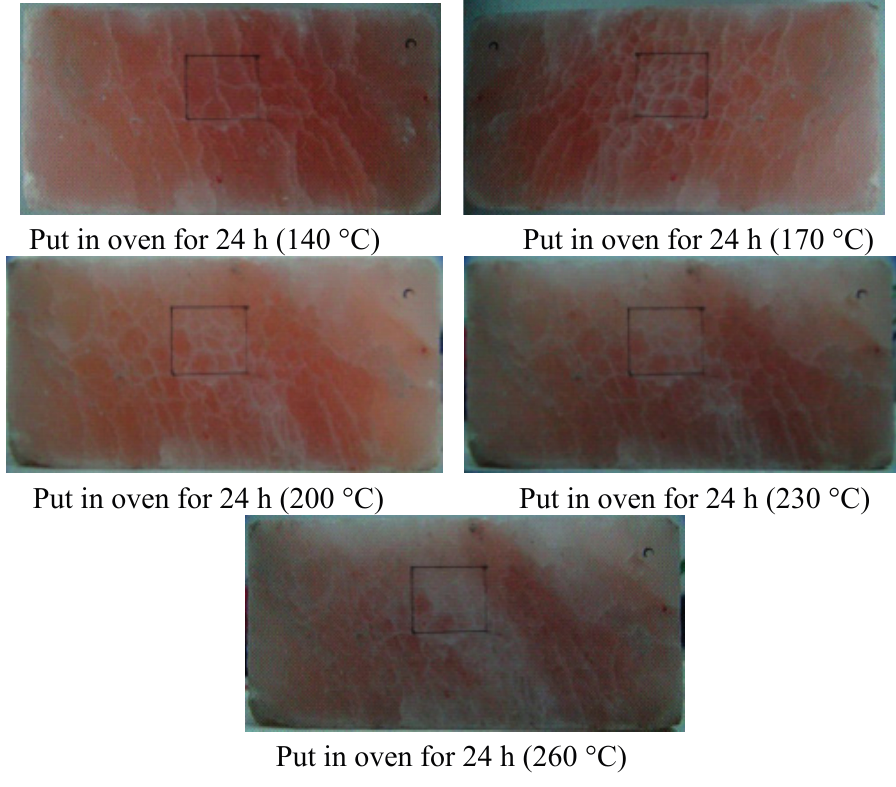
Figure 5. Comparison of the thermal damage cracks on the surface of rock salt in a given temperature region: 18.5 , 50 , 80 , 110 , 140, 170 , 200 , 230 and 260